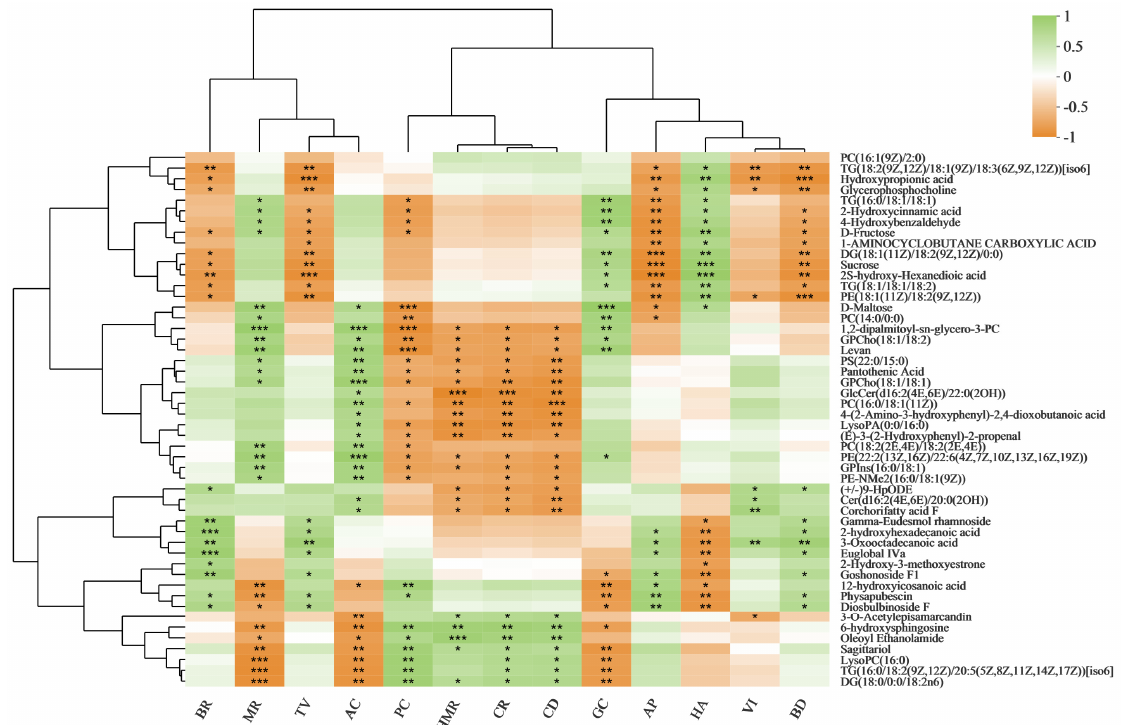
Figure 4. Correlation analysis of rice quality traits and DMs. * p < 0.05, ** p < 0.01, and *** p < 0.001. BR, brown rice rate; MR, milled rice rate; HMR, head milled rice rate; CR, chalkiness rate; CD, chalkiness degree; GC, gel consistency; PC, protein content; AC, amylose content; AP, appearance; HA, hardness; VI, viscosity; BD, balance degree; TV, taste value.